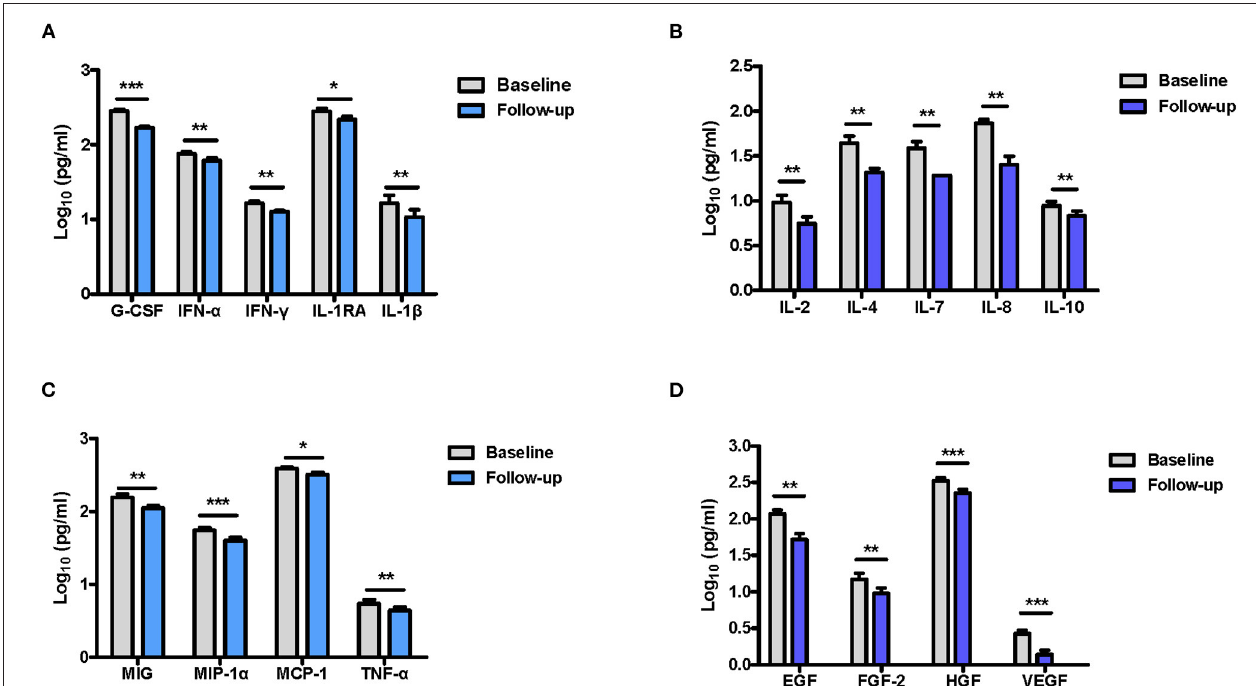
FIGURE 2 | Differences in cytokine levels in FEDF patients with SCZ before and after treatment with antipsychotics. G-CSF, IFN- γ , IFN- α , IL-1RA, and IL-1 β (A) , IL-2, IL-4, IL-7, IL-8, and IL-10 (B) , MIG, MIP-1 α , TNF- α , and MCP-1 (C) , EGF, FGF-2, HGF, and VEGF (D) levels are significantly decreased in the serum of patients after 8 weeks of treatment with antipsychotic medication. SCZ, schizophrenia; FEDF, first-episode, drug-free; G-CSF, granulocyte colony-stimulating factors; IFN, interferon; MIG, monokine induced by interferon- γ ; IL, interleukin; EGF, epidermal growth factor; MIP, macrophage inflammatory protein; HGF, hepatocyte growth factor; VEGF, vascular endothelial growth factor; MCP-1, macrophage chemoattractant peptide-1; FGF-2, basic fibroblast growth factor; TNF, tumor necrosis factor; IL-1RA, interleukin-1 receptor antagonist; * P < 0.05, ** P < 0.01, *** P <